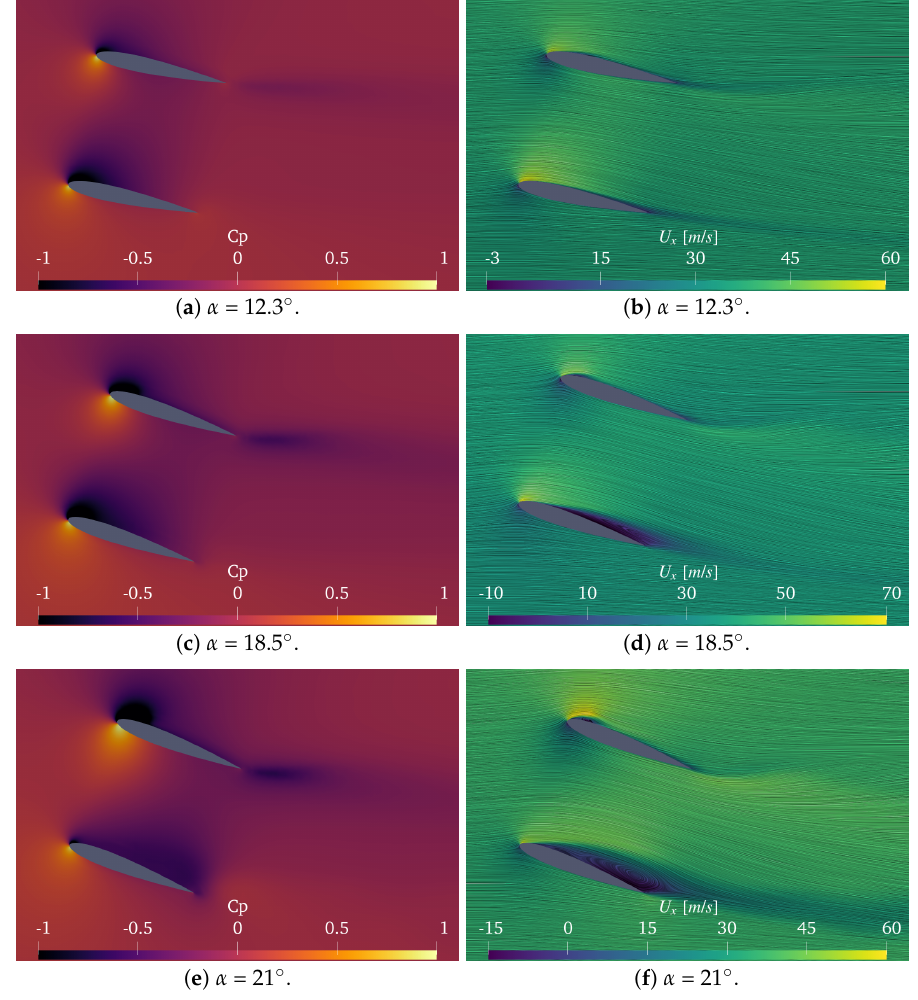
Figure 14. Tip section: C p ( left ) and U x ( right ) contours at different angles of attack (note that colours match different values for each α )